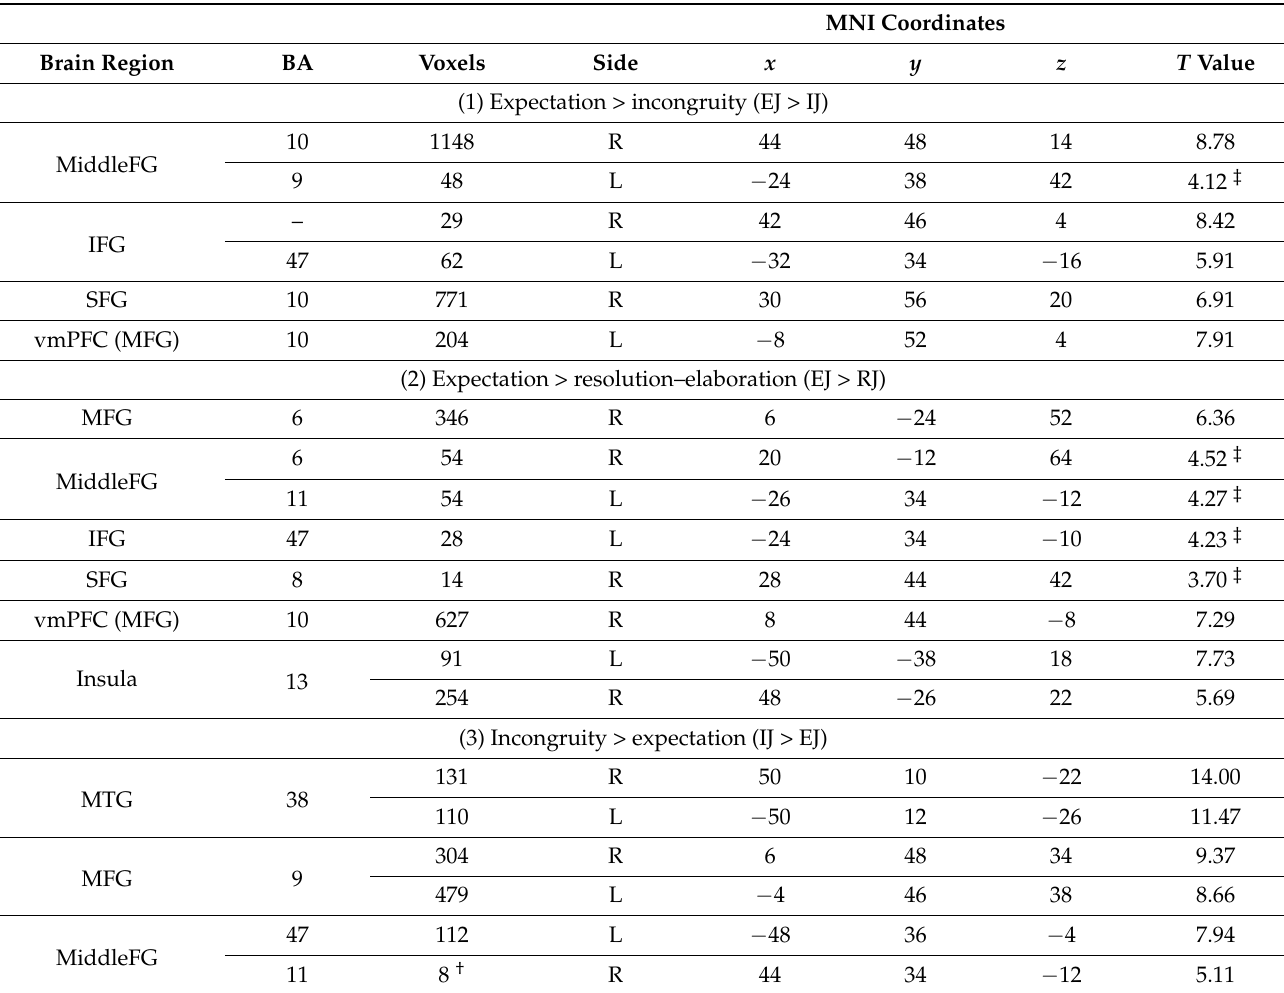
Table 6. Simple main effects of the three stages under the joke